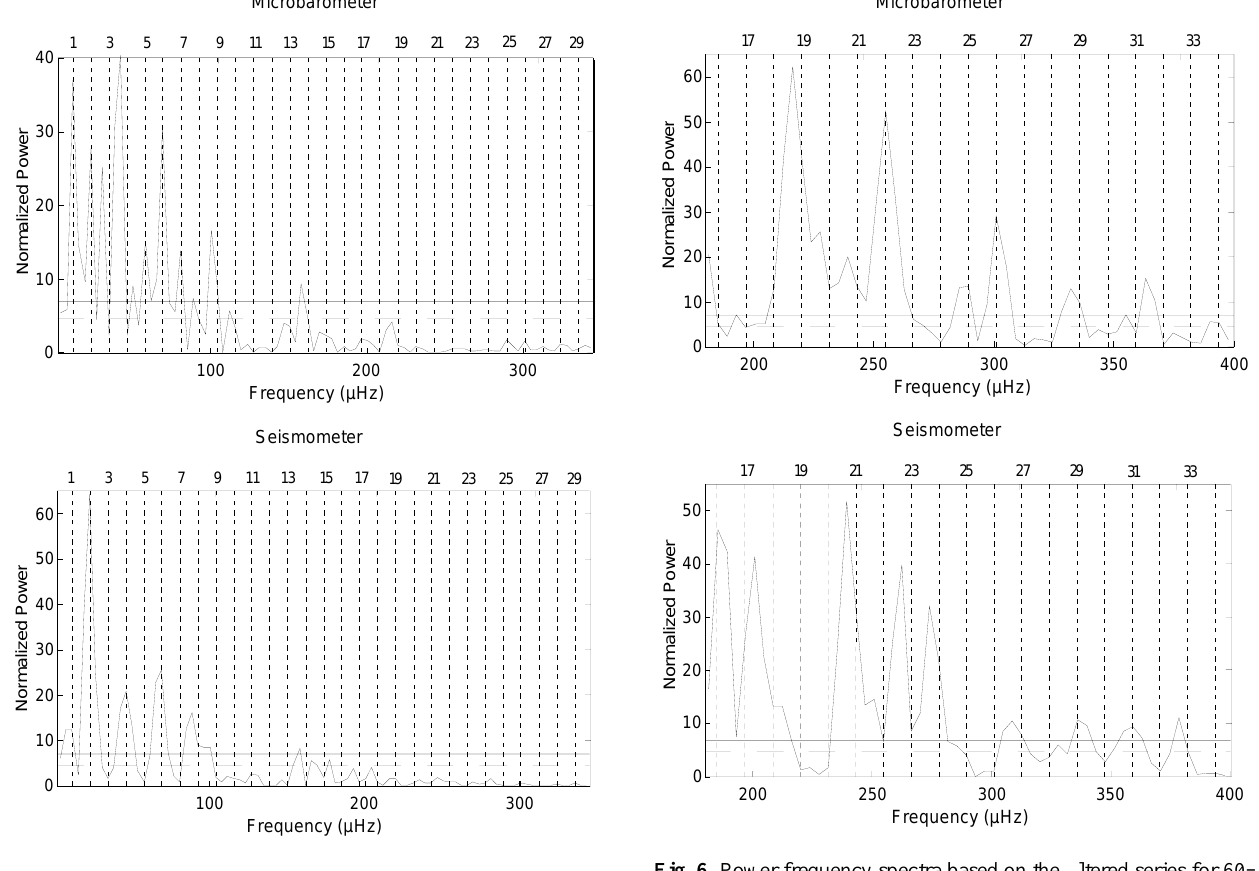
Fig. 5. Fig. 5. Power frequency spectra based on the raw records for 36– 72h time segment from Fig. 4. The horizontal lines show the 99% (dashed) and 99.9% (solid) confidence levels. The vertical dashed lines correspond to the frequencies of solar tide subharmonics. The numbers at these lines indicate subharmonic numbers.